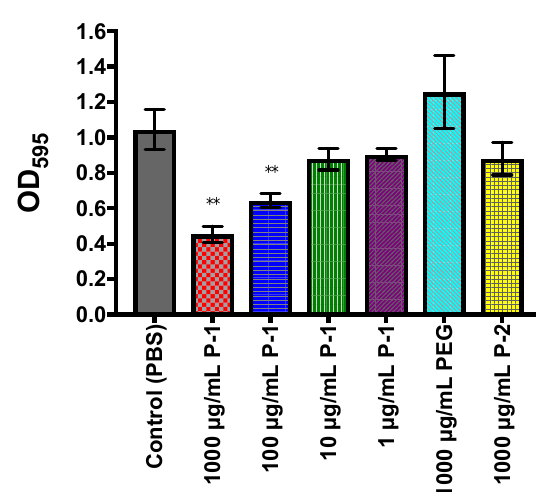
Figure 7. Crystal violet evaluation of polymer-modulated P. aeruginosa biofilm formation. Total biomass dependence on polymer concentration after 24 hours of incubation in the presence of P-1, PEG, or P-2. PBS was used as a positive control. The experiment was performed in duplicate, and the absorbance was determined as the average of data for each experiment. The data points and error bars represent the average and s.d from data in three independent experiments ( n = 3), with significance (** p ≤ 0.01) indicated against control (PBS).